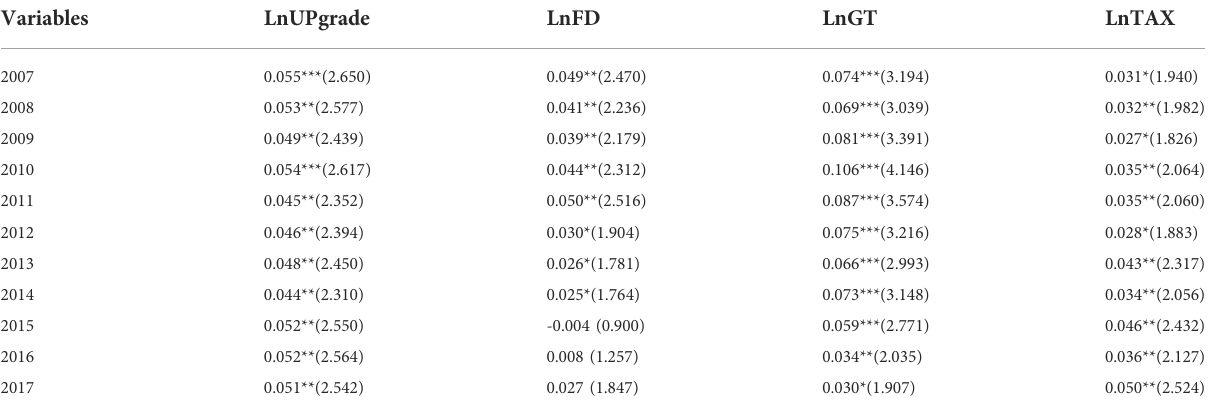
TABLE 6 Results of global Moran ’ s I from 2007 to 2017. Variables LnUPgrade LnFD LnGT